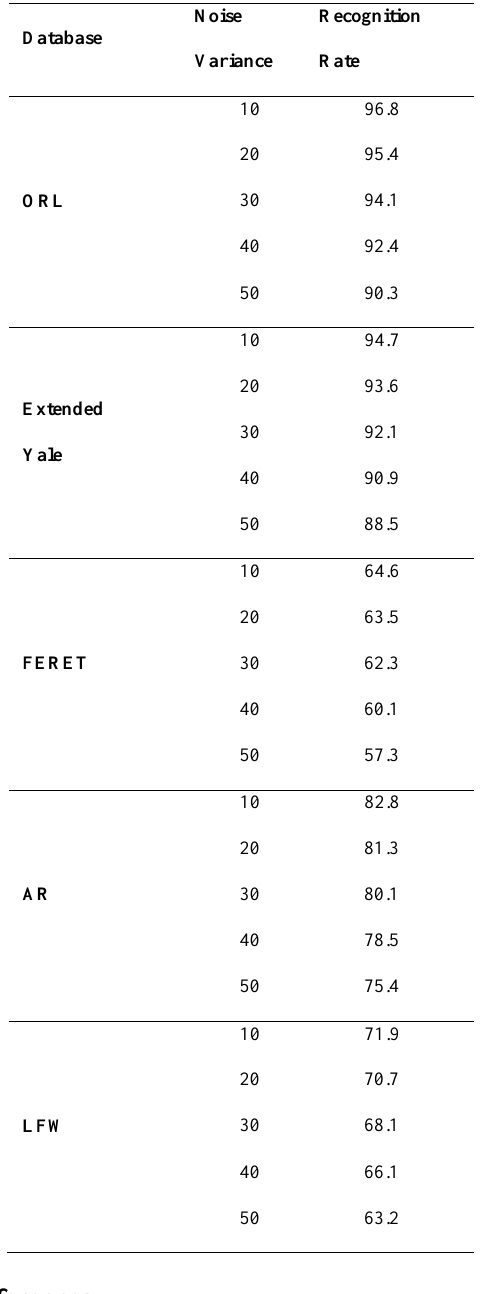
Table 2. Recognition rate for noisy images. Database